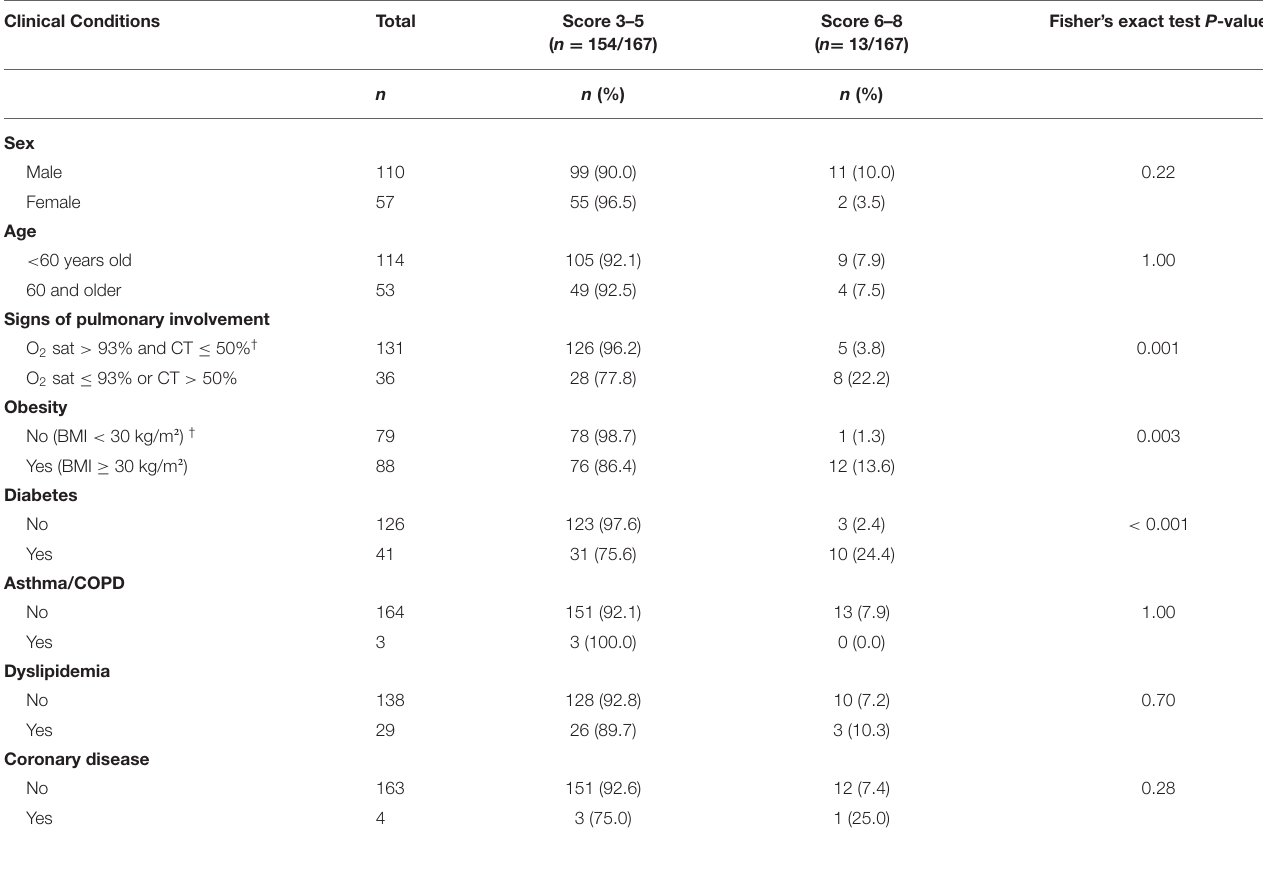
TABLE 1 | Baseline patient characteristics by primary outcome*. Clinical